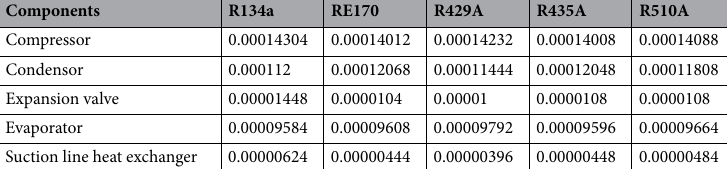
Table 4. Entropy generation in various components